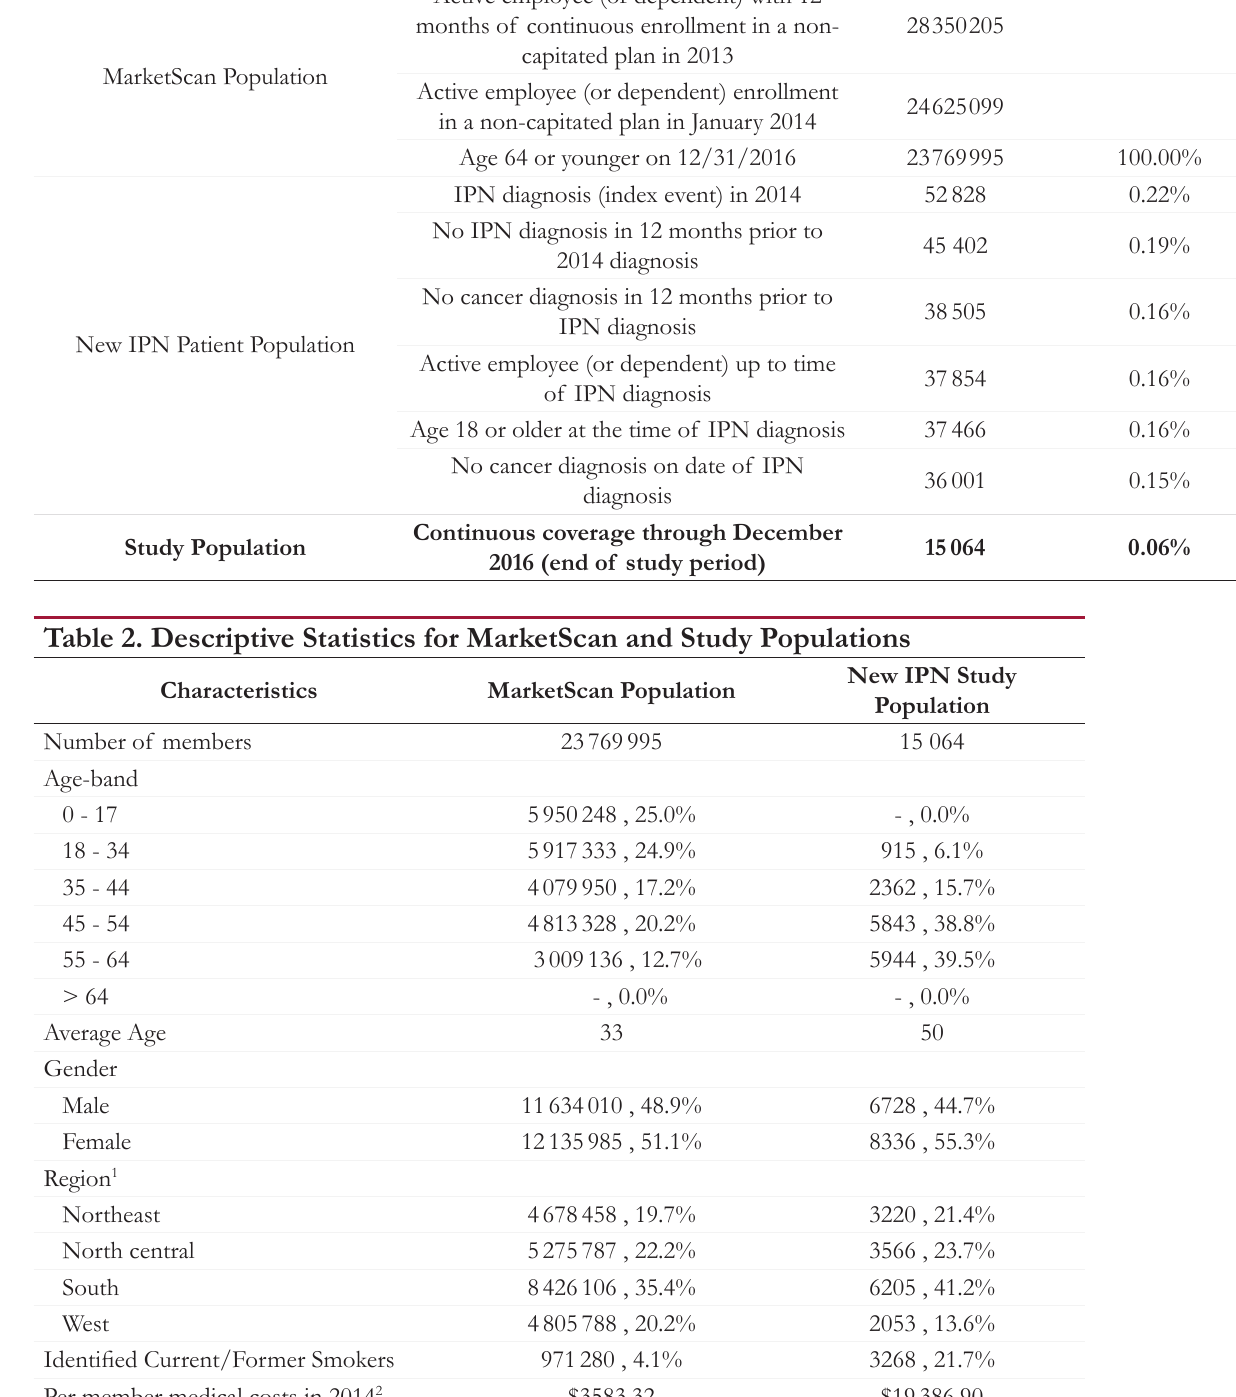
Table 1. Determination of Study Population Population